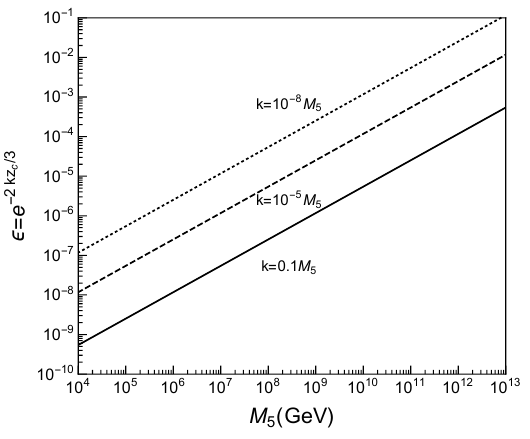
Figure 2 . The expansion parameter, " (cid:17) e (cid:0) 2 3 kz c , as a function of the 5D Planck mass M 5 . The 5D curvature scale is chosen to k = 0 : 1 M 5 ; 10 (cid:0) 5 M 5 ; 10 (cid:0) 8 M 5 , in solid, dashed and dotted